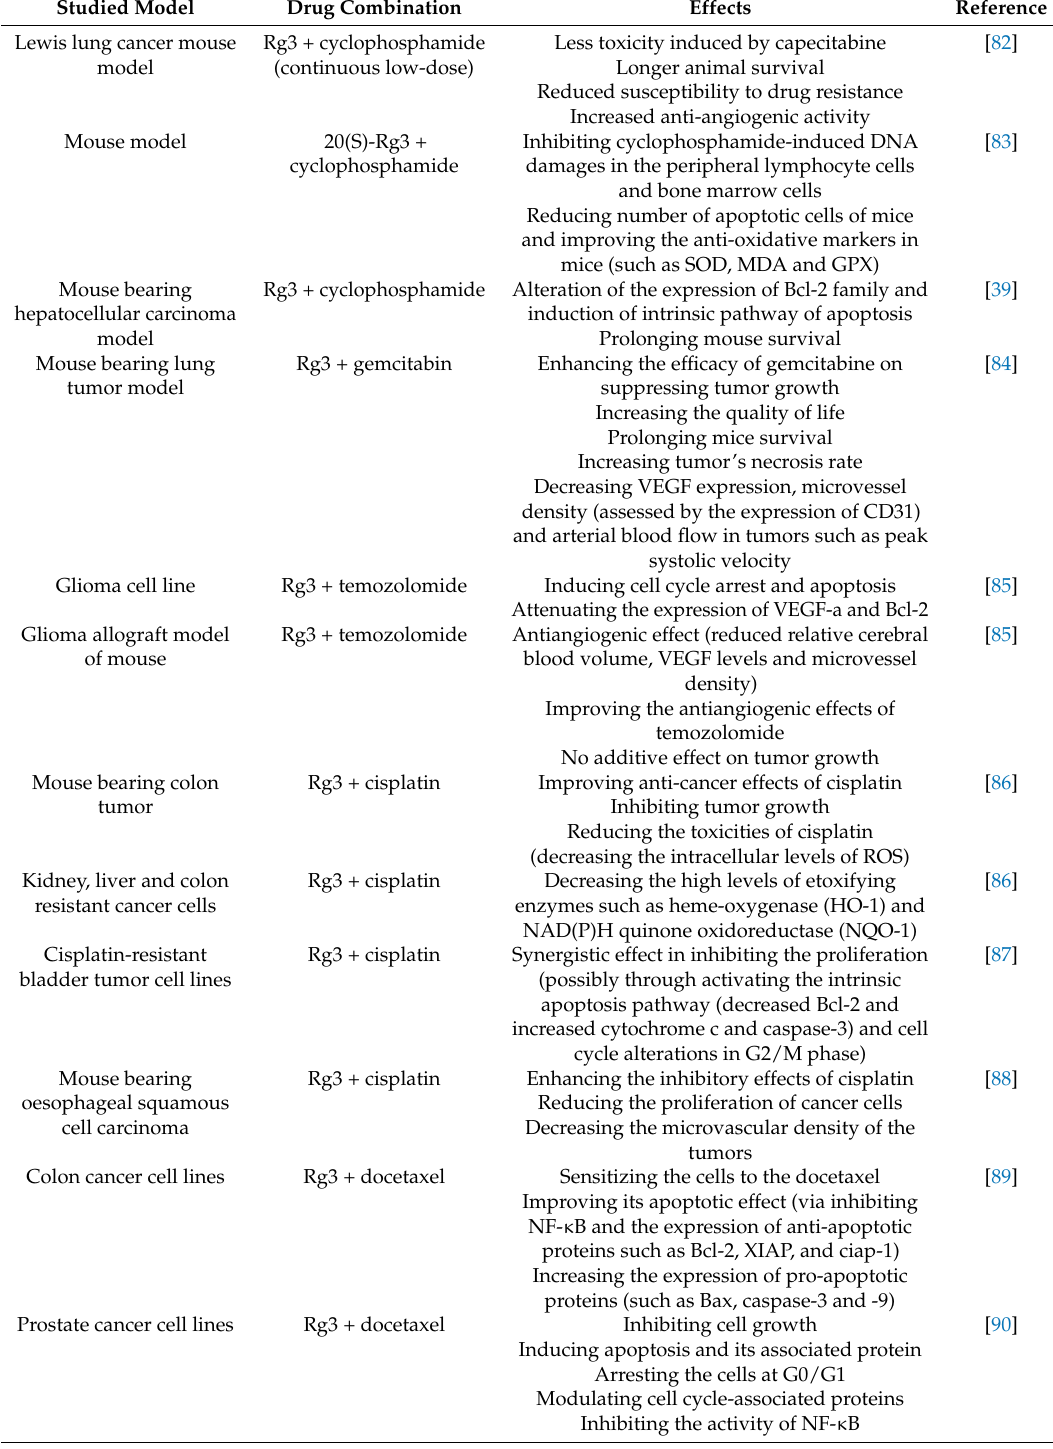
Table 3. Suggested effects of Rg3 in combination with chemotherapy agents in in vitro and in vivo